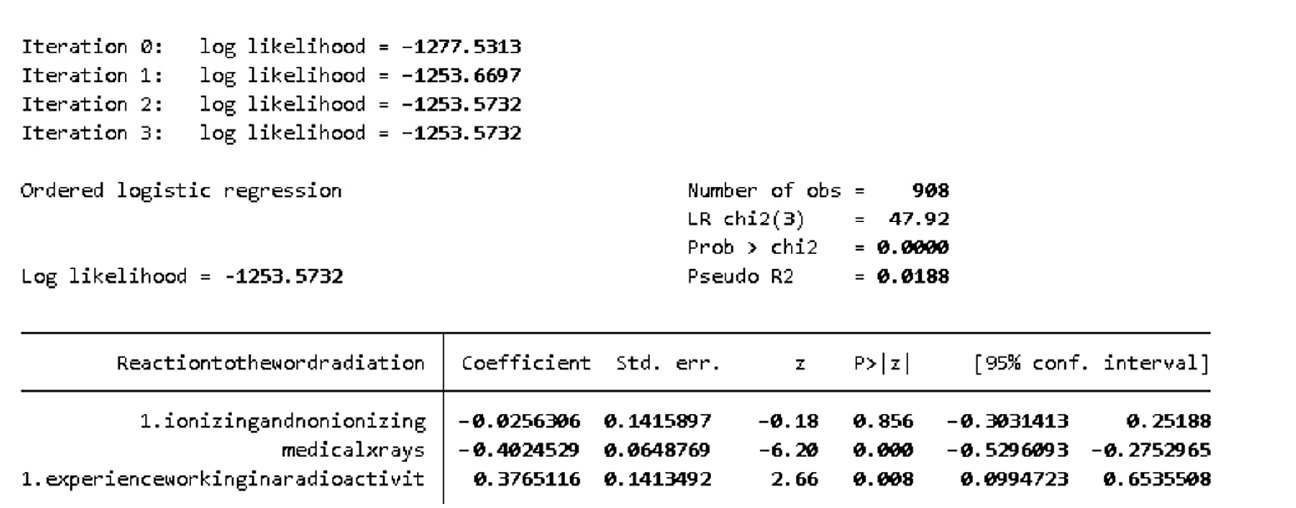
Figure A1. Model 1: Predicting survey respondents’ reaction to the word radiation using ordered logistic regression in STATA.